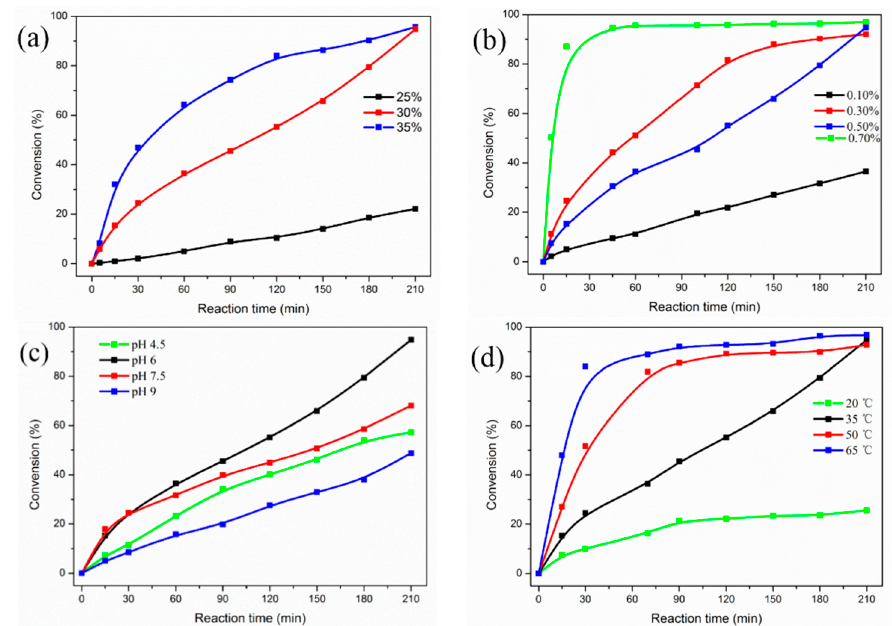
Figure 1. Conversion versus time curves showing the effects of reaction conditions on conversion. Effect of: ( a ) total monomer concentration, ( b ) initiator concentration, ( c ) pH, and ( d ) reaction temperature.